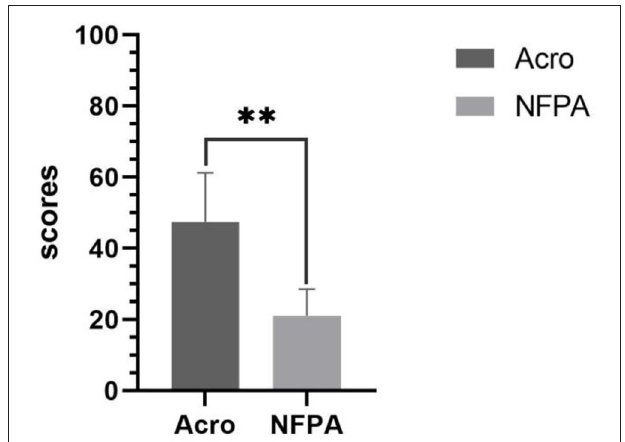
FIGURE 1 | Body image concern in patients with acromegaly vs. those with NFPA. Data are presented as mean ± standard deviation. Acro, acromegaly; NFPA, nonfunctional Pituitary Adenoma. **Correlation is significant at the 0.01 level